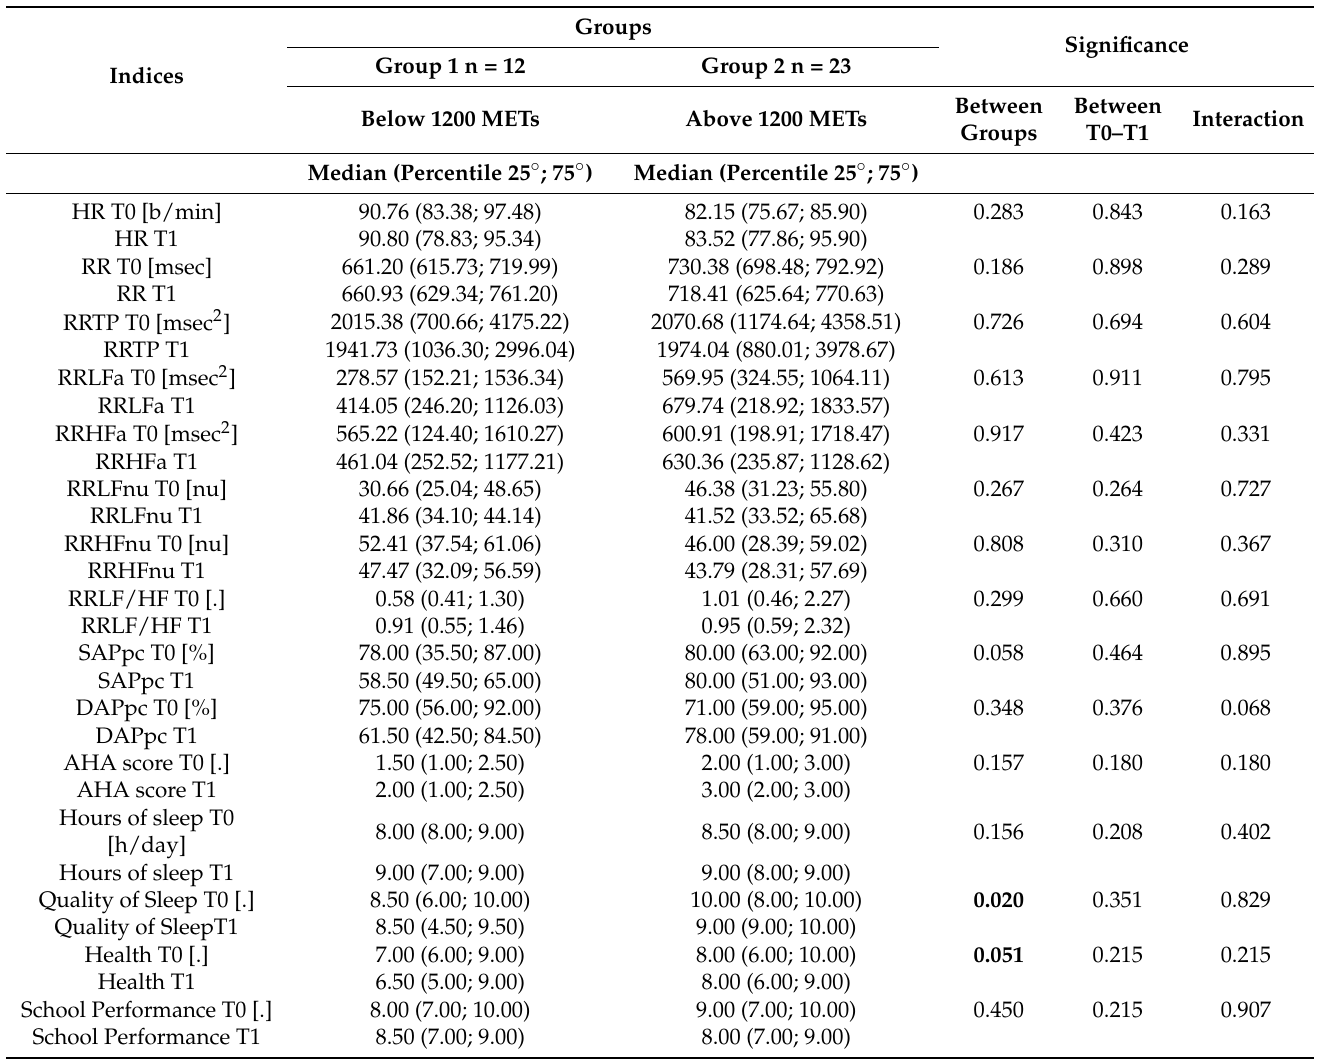
Table 1. Summary of descriptive data of the study population subdivided into two groups considering total volume of physical activity (METsTOT) (Subdivision